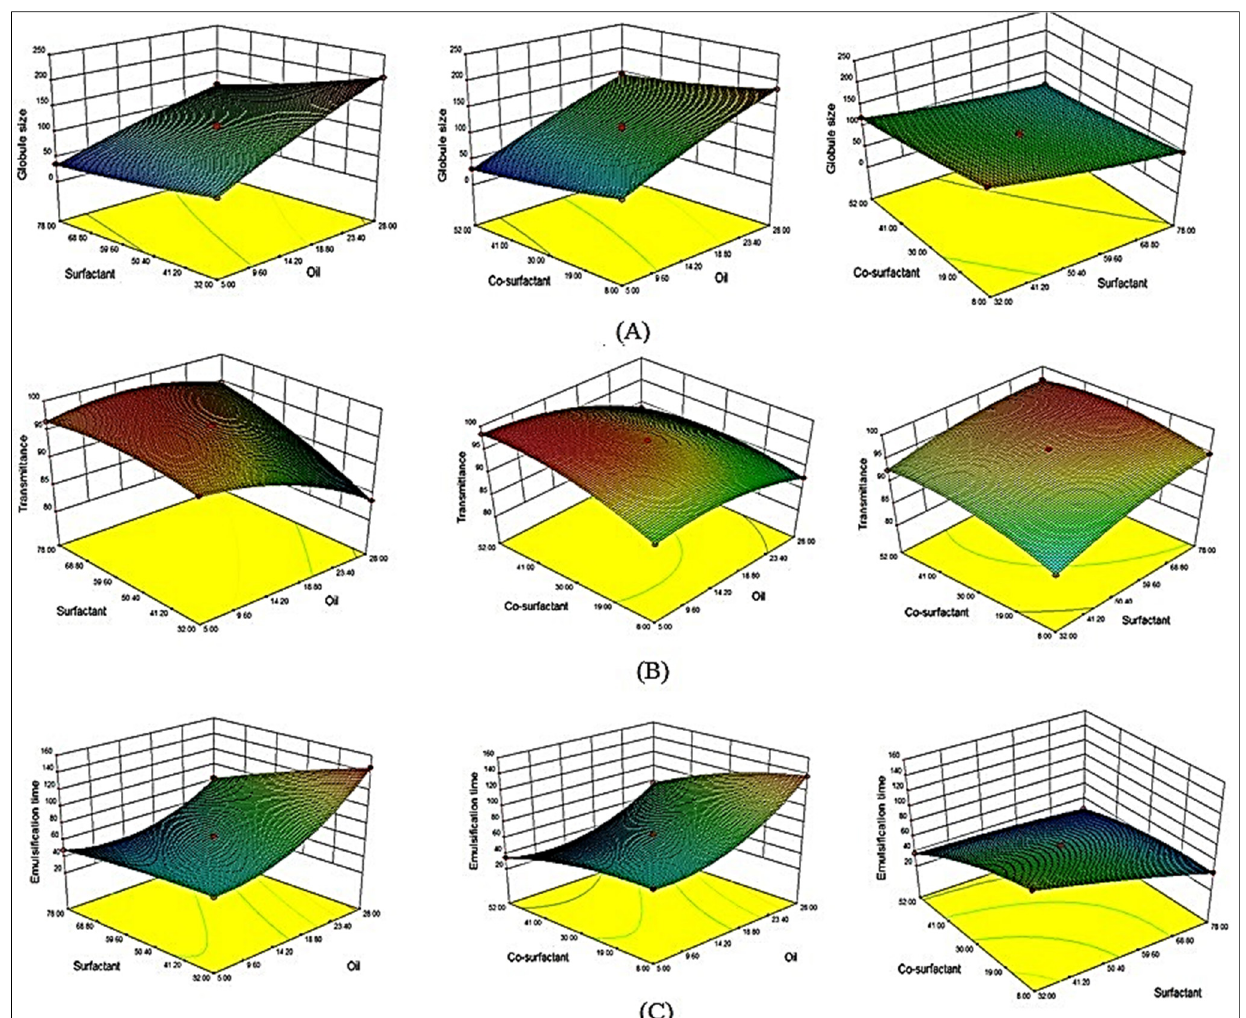
Figure 3. A. 3D surface response diagram of CEP-SNEDDS indicating the influence of independent variables on ( A ). Globule size as Y 1 , ( B ). Percent transmittance as Y 2 , ( C ). Emulsification time as Y 3